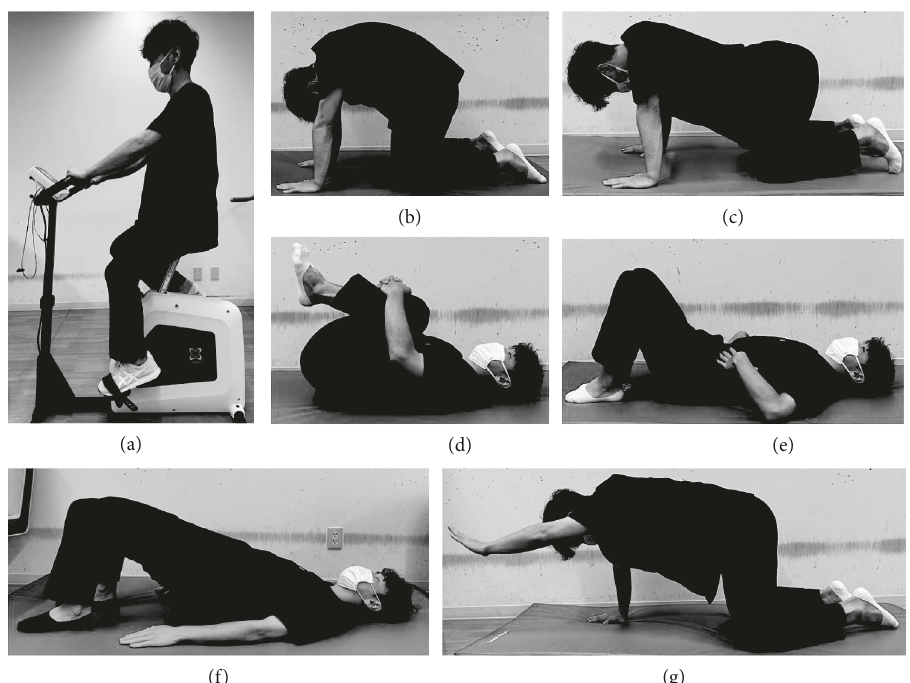
Figure 1: Exercises included in the program. (a) Ergometer: 20–30 minutes. (b)-(c) Cat and dog: 10 repetitions per set. (d) Stretching: 1–3 repetitions per set for each muscle, each held for 30–40 seconds. (e) Draw-in:10 repetitions per set, each held for 10 seconds. (f) Back bridge: 3 repetitions per set, each held for 10 seconds. (g) Hand and knee. 3 repetitions on both the right and left side per set, each held for 5–30